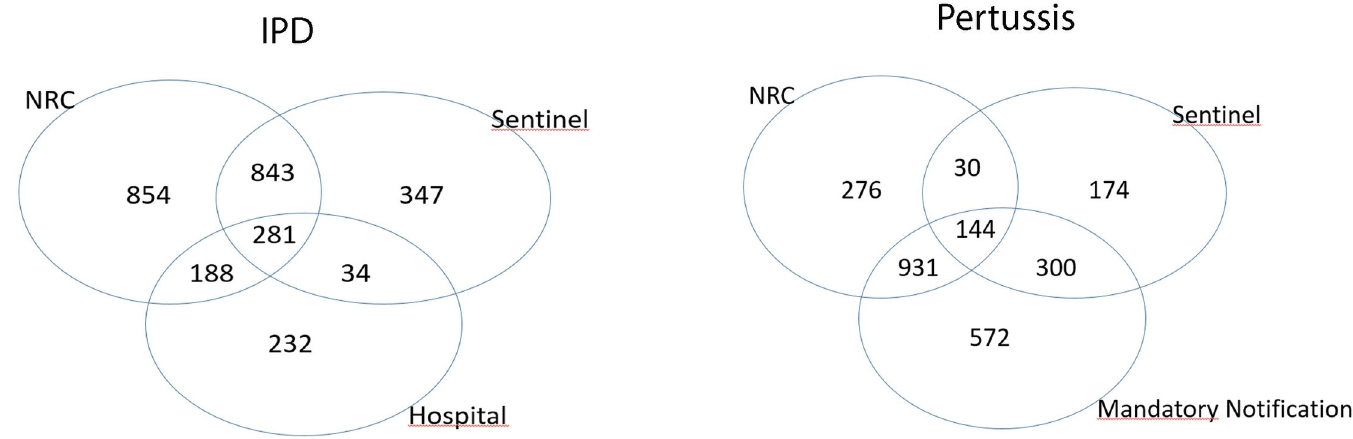
Fig 7. Overview of the IPD (left) and pertussis (right) data after